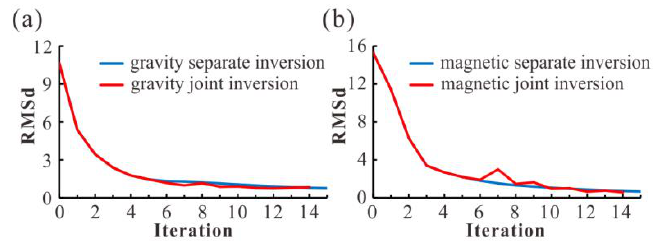
Figure 17. RMSd of inversion. ( a ) RMSd of gravity; ( b ) RMSd of magnetic.